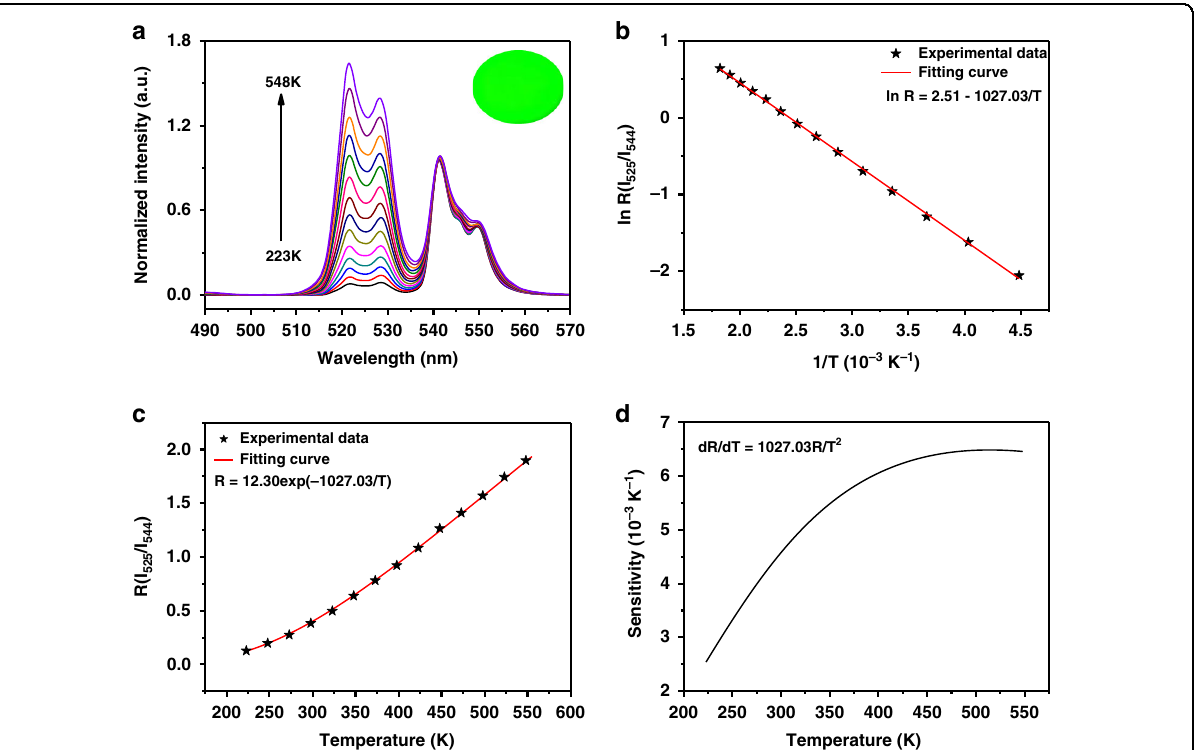
Fig. 5 Temperature-dependent luminescence properties of NBFYE HNPs synthesized by adding 1.5 g PAA and 5 mL H 2 O to the reaction system. a Normalized emission spectra of NBFYE HNPs as a function of temperature upon NIR irradiation ( P = 4.85 W cm − 2 ). The inset in the upper right corner shows the luminescence photograph of HNPs under 980 nm NIR irradiation at room temperature. b The linear relationship between the natural logarithm of R ( I 525 / I 544 ) vs 1/T. c R ( I 525 / I 544 ) as a function of temperature. d The sensing sensitivity of NBFYE HNPs varies with temperature from 223 K to 548